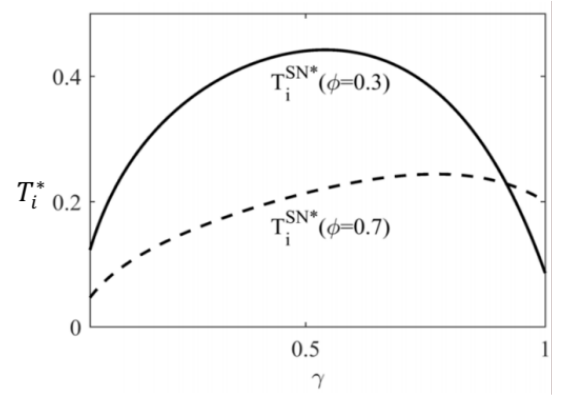
Figure 3. SN contract